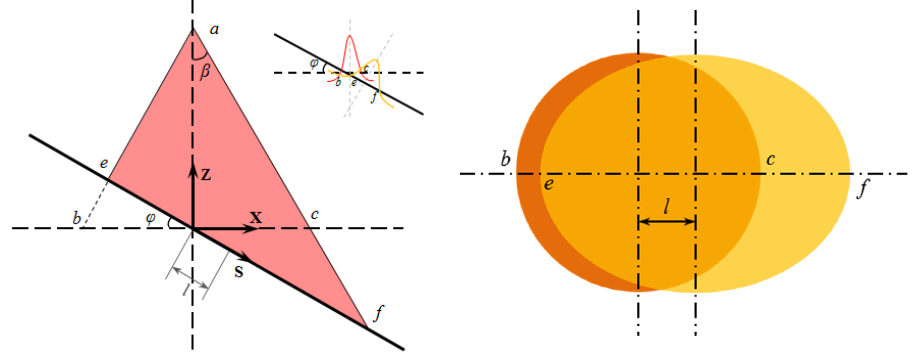
Figure 2. Gaussian distribution model diagram of laser beam.